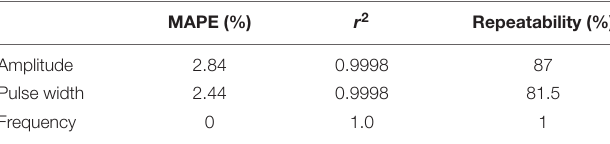
TABLE 4 | Results of the statistical quantities obtained from the characterization measurements of the stimulation parameters. MAPE (%) r 2